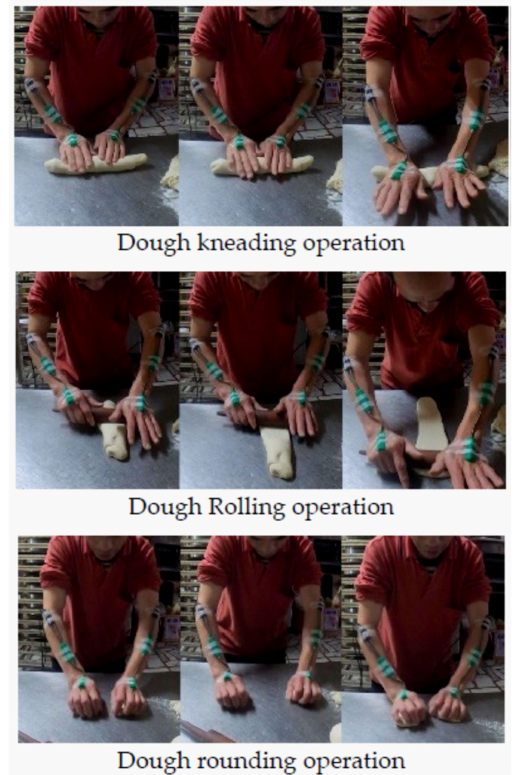
Figure 1. Three types of tasks usually performed by bakery